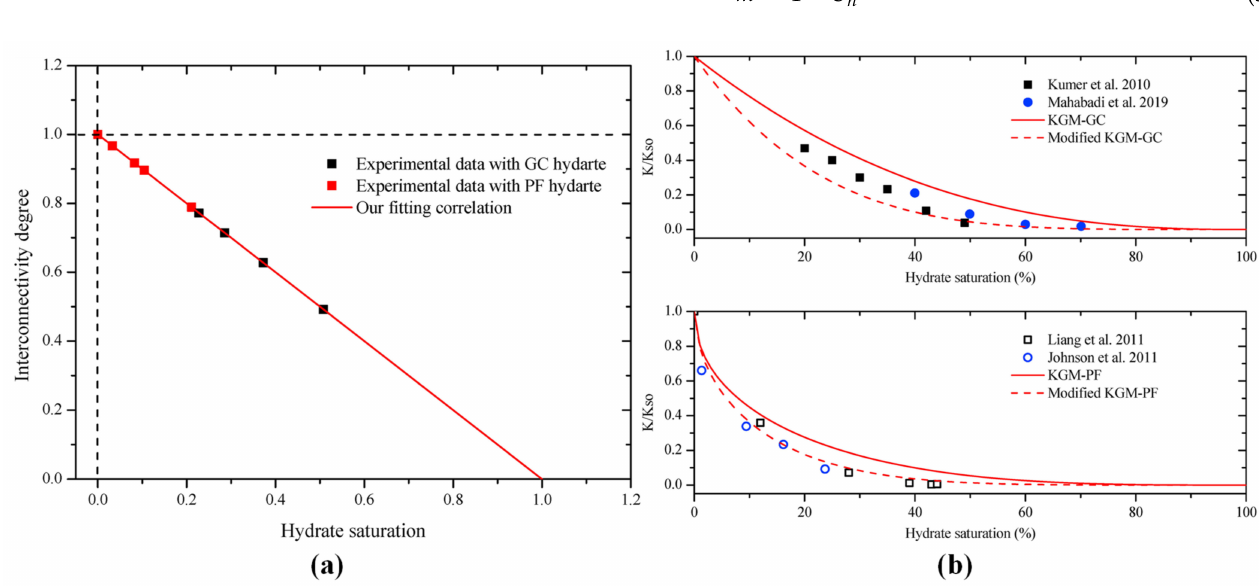
Figure 17. Dependence of interconnectivity degree and normalized permeability on hydrate satura- tion reprinted from [103] with permission from Elsevier. ( a ) Interconnectivity degree; ( b ) normalized permeability with experimental data [27,82,89,95] and analytical results [23]. Note: Please refer to the original literature for the experimental data points shown in the